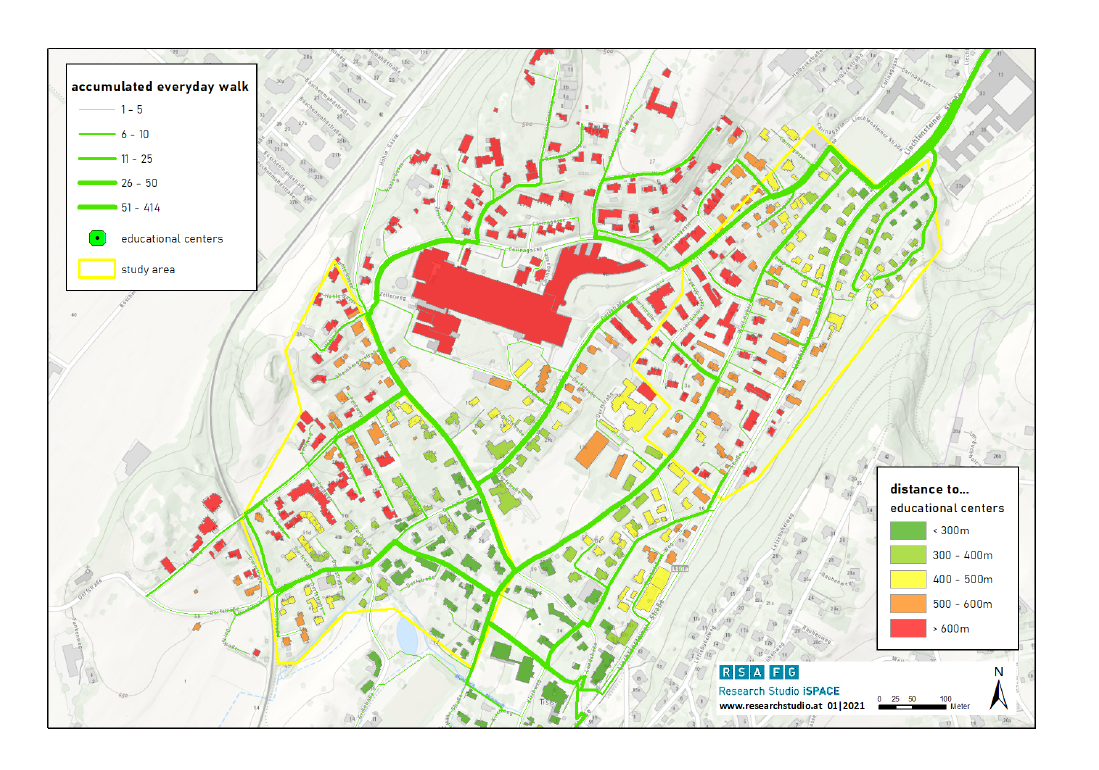
Figure 3. Accumulated everyday walks and accessibility of educational centers in Tisis, Feldkirch (own illustration).